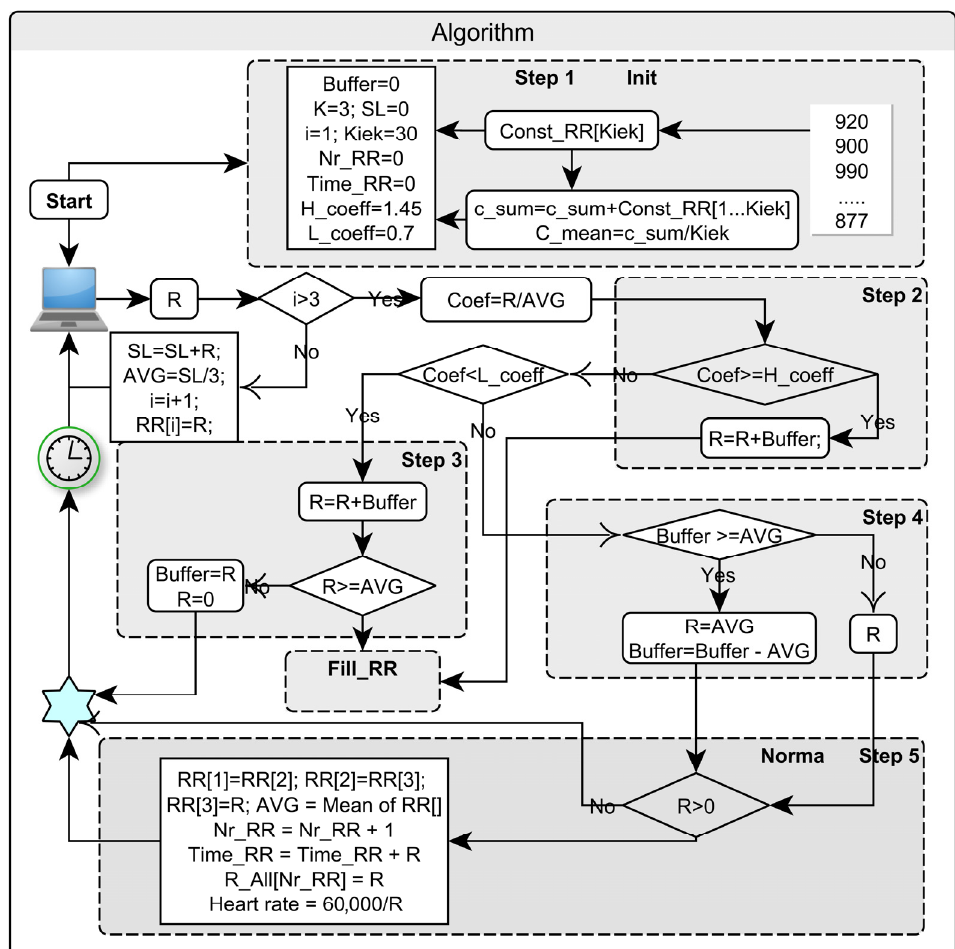
Figure 1. The stepwise procedure of adaptive algorithm (R—input of RR interval from file or device; AVG—average of 3 RR intervals; Coef—division of RRI and average; L_coeff and H_coeff—minimal and maximal criteria; RR[ ]—array of normal RRI; Time_RR—counter of time; Buffer—reserve of RR interval) .